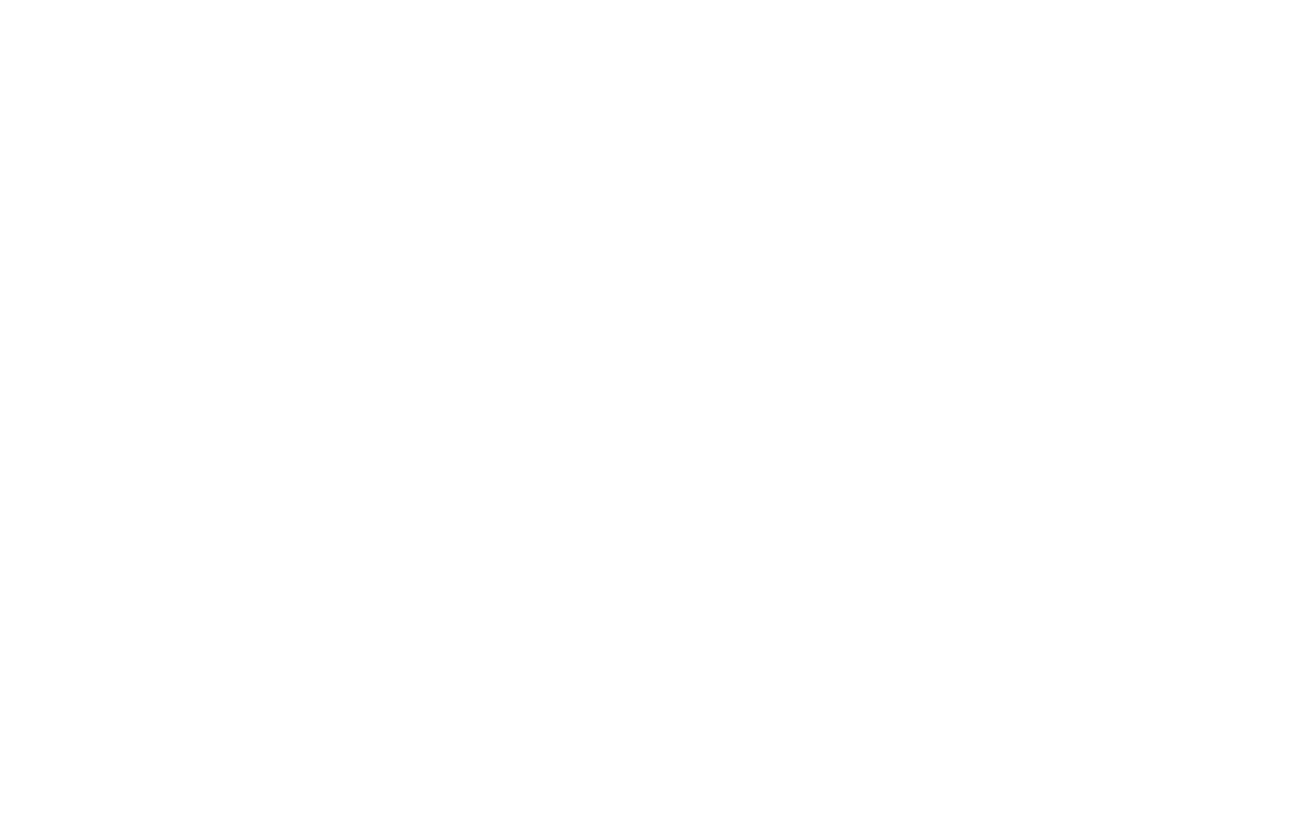
Frontiers in Microbiology |